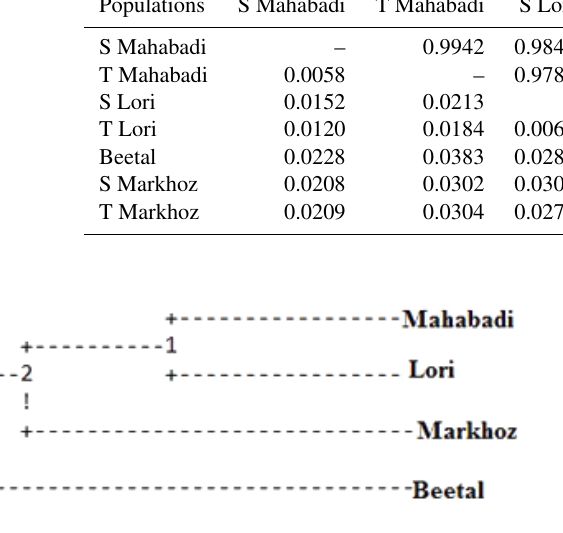
Figure 1. The phylogenetic dendrogram showing the genetic rela- tionships between goat populations using the Nei (1978) standard genetic distance obtained from five ISSR markers.